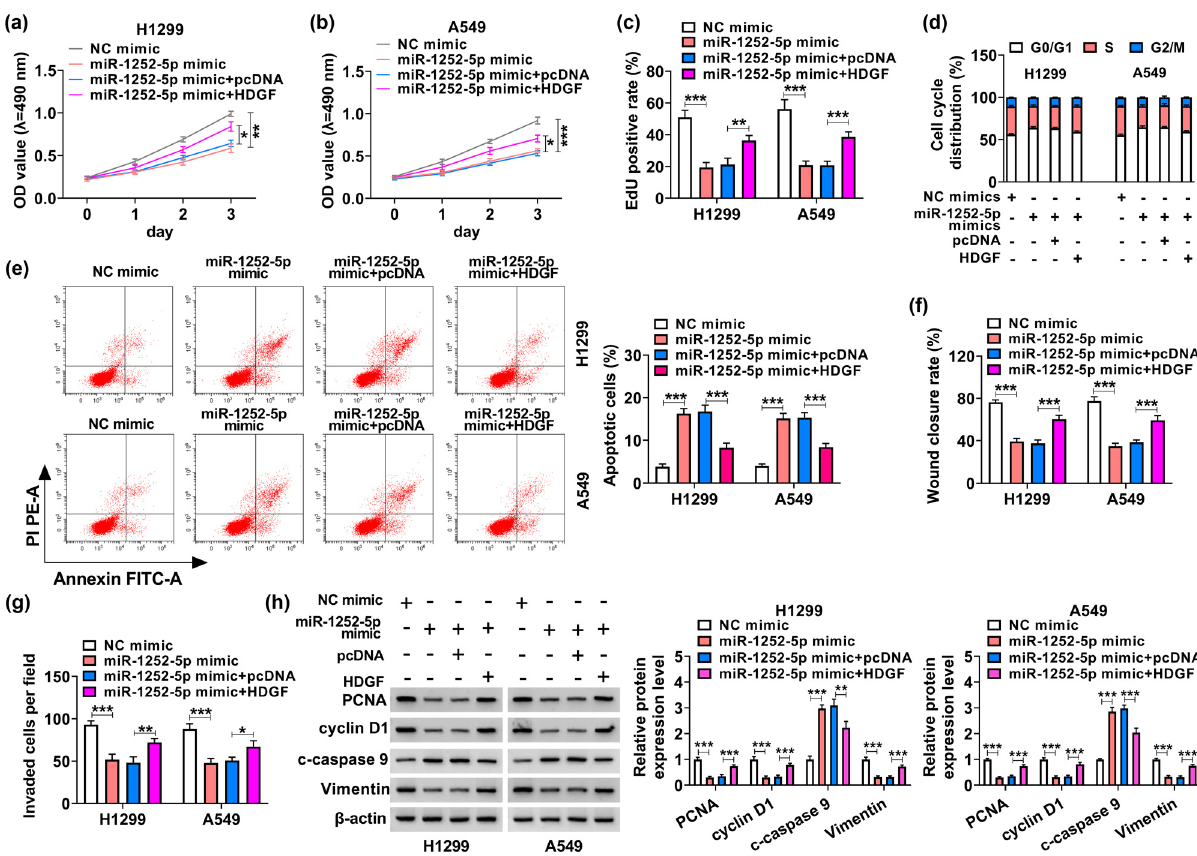
Figure 5: Overexpressing miR - 1252 - 5p suppressed the development of NSCLC cells through HDGF. H1299 and A549 cells transfected with NC mimic, miR - 1252 - 5p mimic, miR - 1252 - 5p mimic + HDGF vector, or miR - 1252 - 5p mimic + pcDNA vector. ( a and b ) MTT assay monitored the OD value at 490 nm. ( c ) EdU assay determined the EdU positive rate. ( d and e ) FCM method analyzed the cell cycle distribution ( % ) and apoptotic cells ( % ) . ( f ) Scratch wound assay measured the percentage of wound closure rate. ( g ) Transwell assay examined the invaded cells per fi eld ( 100 ×) . ( h ) Western blotting detected the relative protein expression levels of PCNA, cyclin D1, c - caspase 9, and vimentin in transfected cells, normalized to β - actin. * P < 0.05, ** P < 0.01, and *** P <